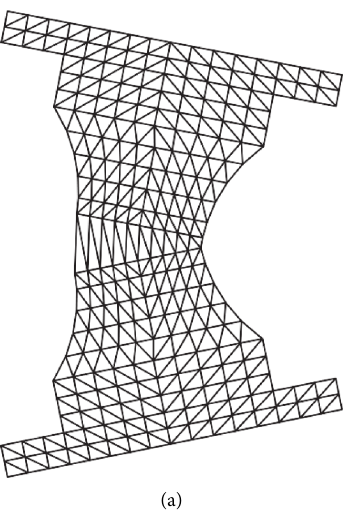
Figure 14: Rigid body motion: (a) deformed mesh and (b) principal stresses.